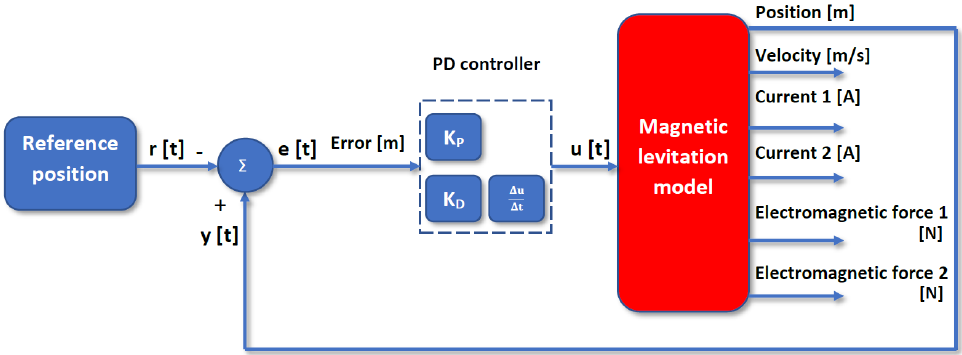
Figure 2. Magnetic levitation system with PD